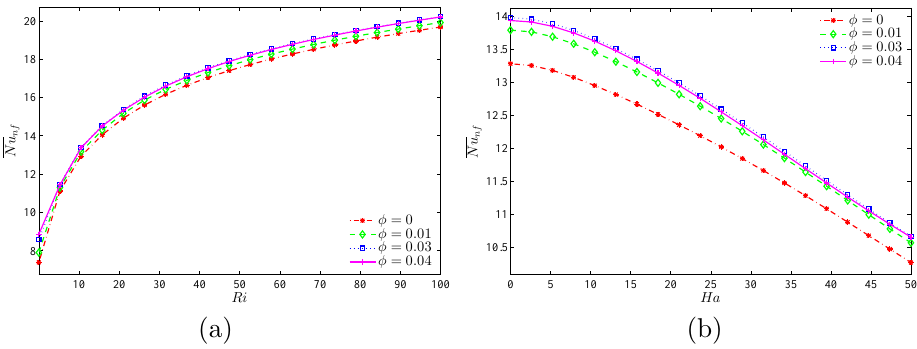
Figure 14. Plots of the average Nusselt number vs. ( a ) Ri and ( b ) Ha for different φ at D =